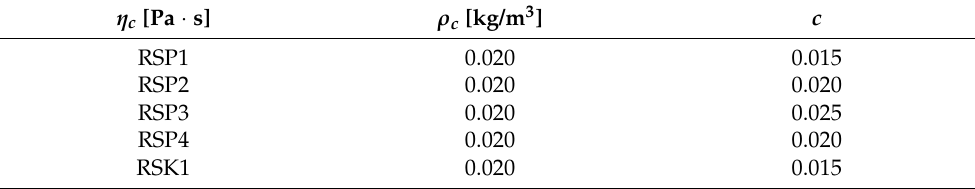
Table 1. Summary of the constant c z values estimated on the basis of Equation (4)